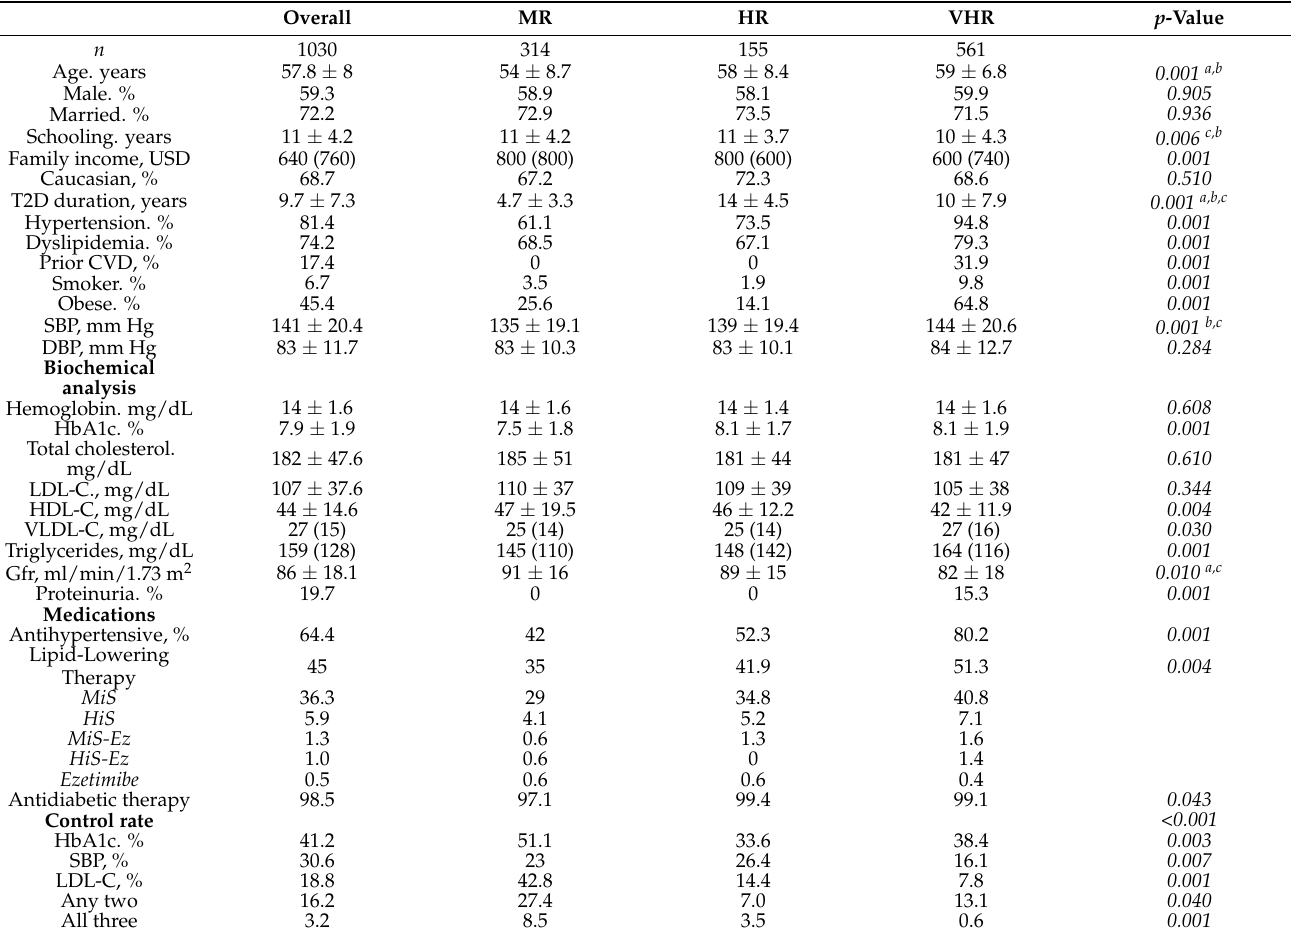
Table 1. Baseline characteristics per cardiovascular risk